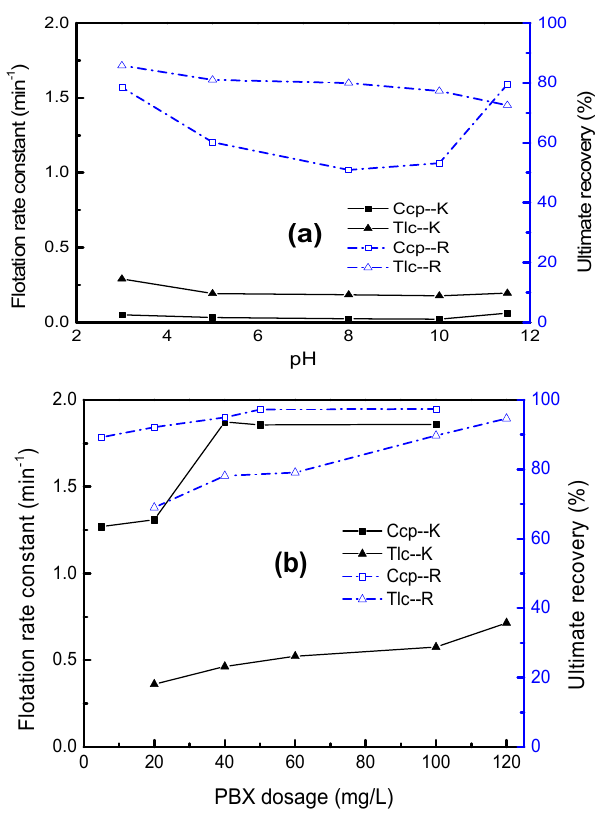
Figure 3. Influence of pH or collector dosage on K(cid:3365) and R. ( a ): collectorless, ( b ): collector.